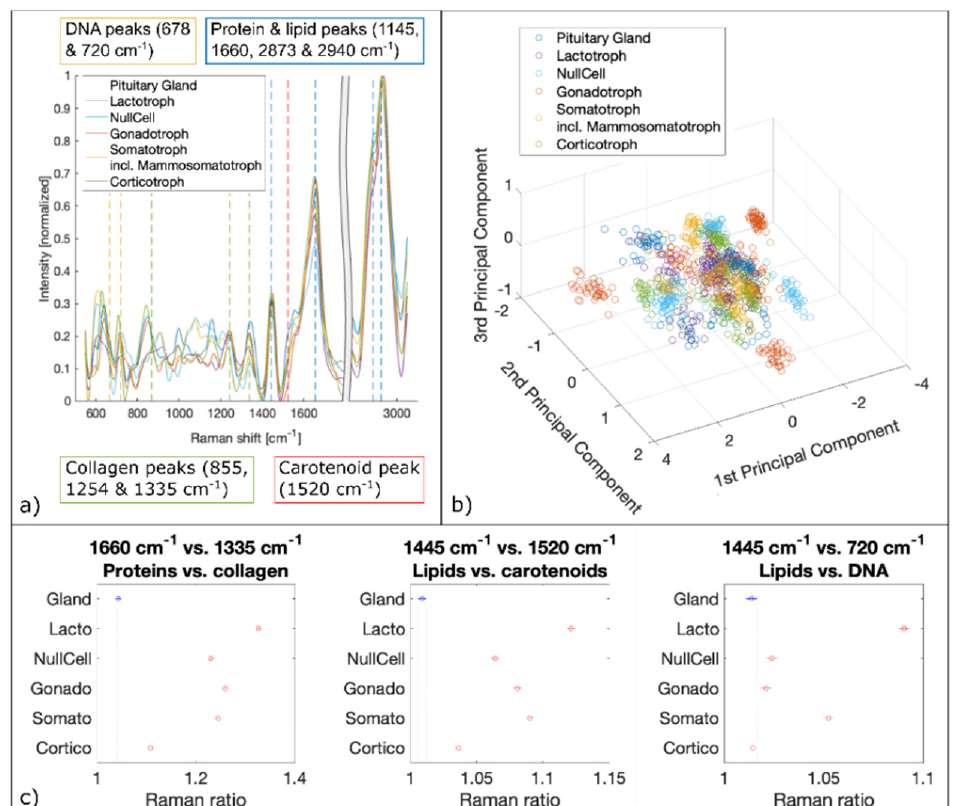
Figure 7. Spectral analysis of Raman data. ( a ) Mean Raman spectra of pituitary gland and pituitary adenoma subtypes. Raman bands of DNA, collagen, carotenoid, proteins and lipids are marked which are identified by PCA as significant differences. ( b ) 3D scatter plot of the three first principal components derived from PCA. ( c ) Raman ratios identified as the most significant discriminators via PCA.